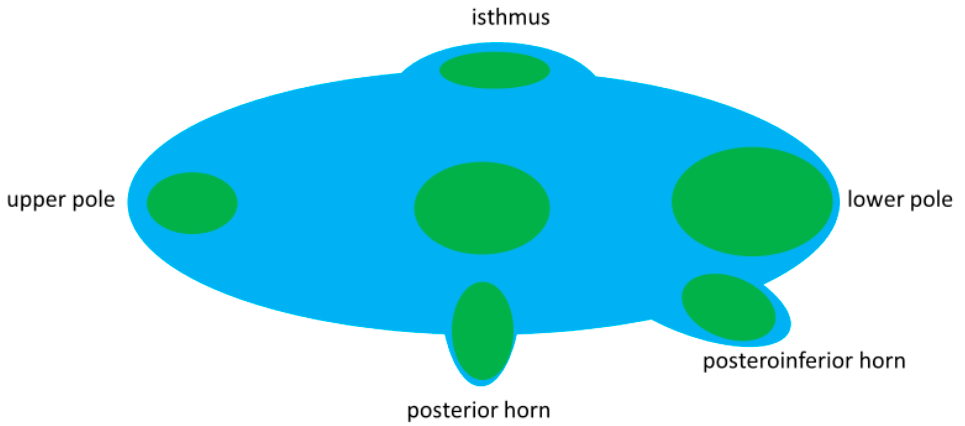
Figure 7. Pole concept of goiter growth. Nodule growth follows the shape of the respective pole. Overstressed depiction of nodule growth along the pole model.